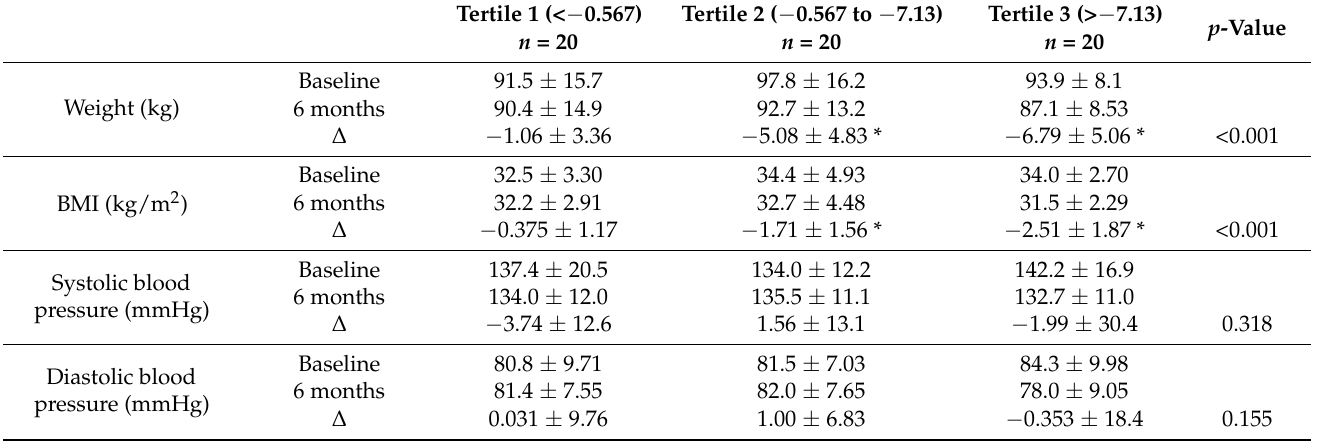
Table 1. Changes in anthropometric and biochemical characteristics of adults with nonalcoholic fatty liver disease (NAFLD) categorized by tertiles after 6 months of lifestyle intervention in intrahepatic fat content